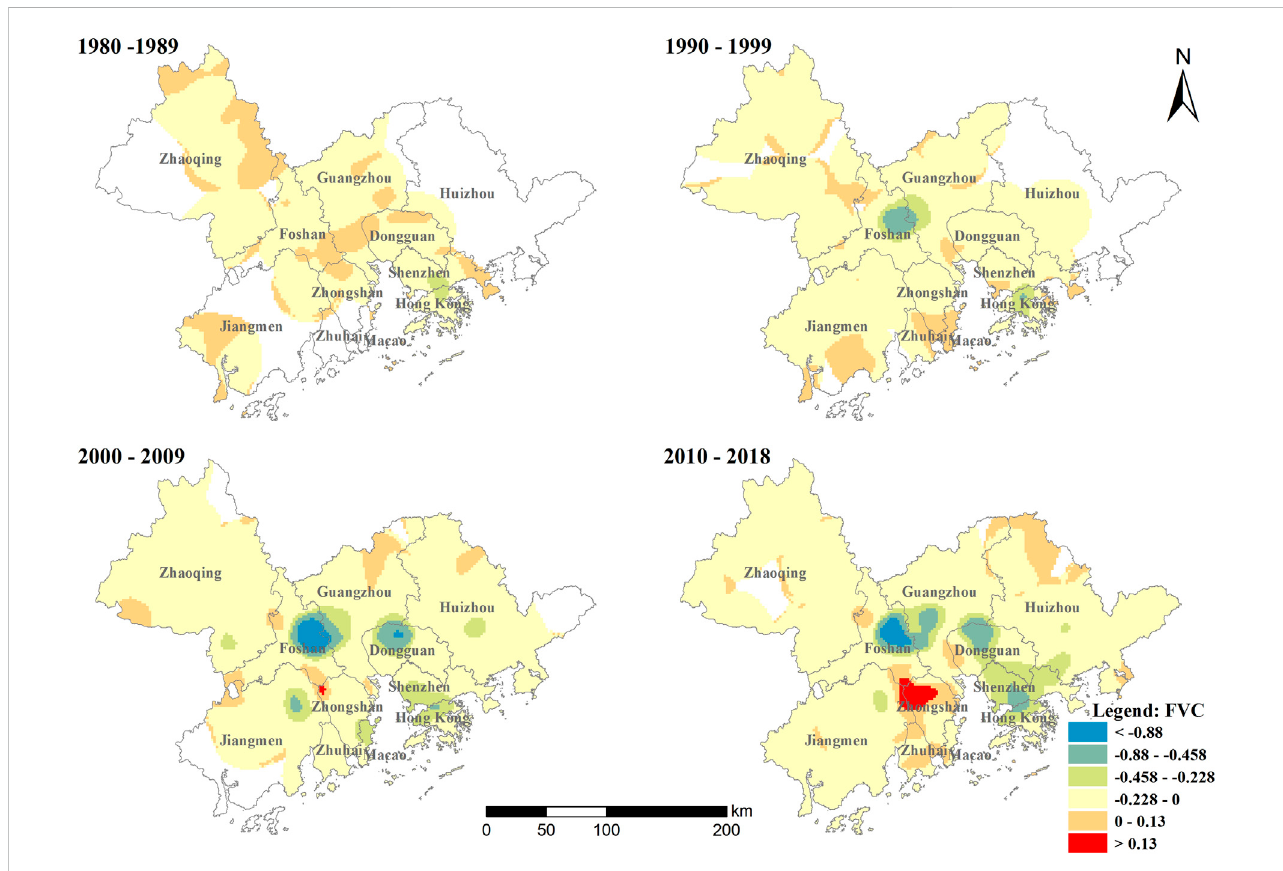
FIGURE 7 Spatial distribution of regression coef fi cients for FVC during 1980 –